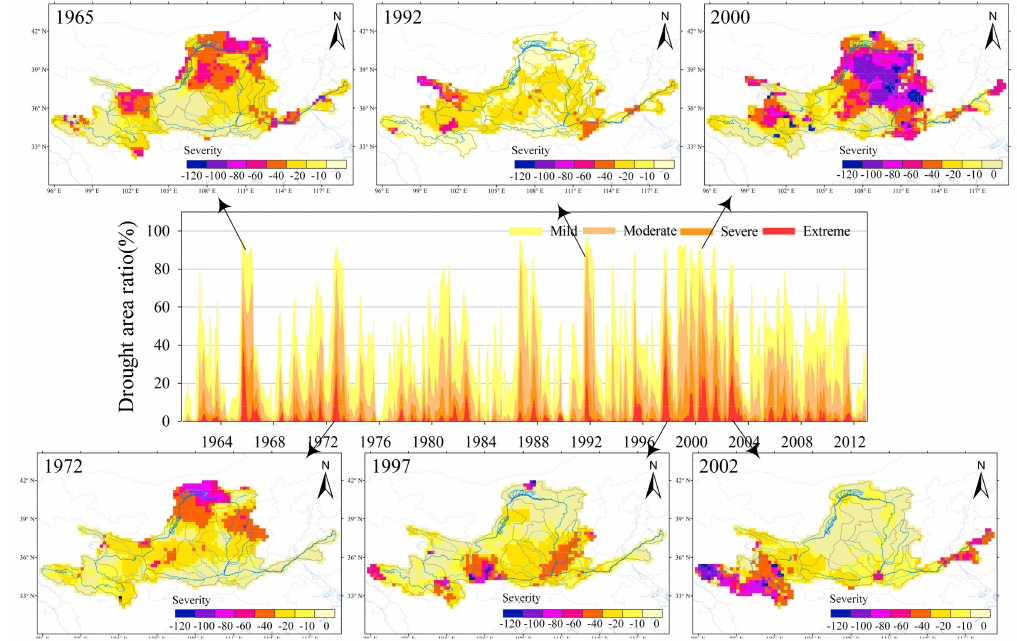
Figure 11. Time series of drought area at mildly to extremely dry levels by VIC-scPDSI9. The small rectangle panels show the spatial distribution of accumulated drought severity for six typical drought events.